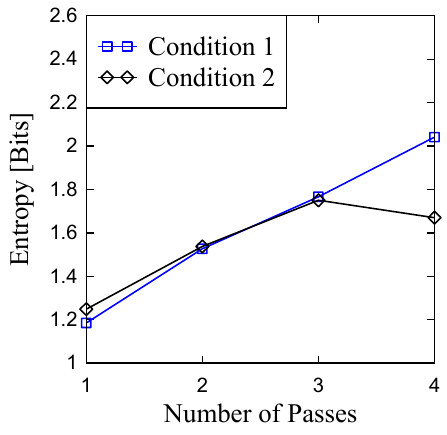
Figure 15. Entropy of the ground surfaces due to multiple passes.